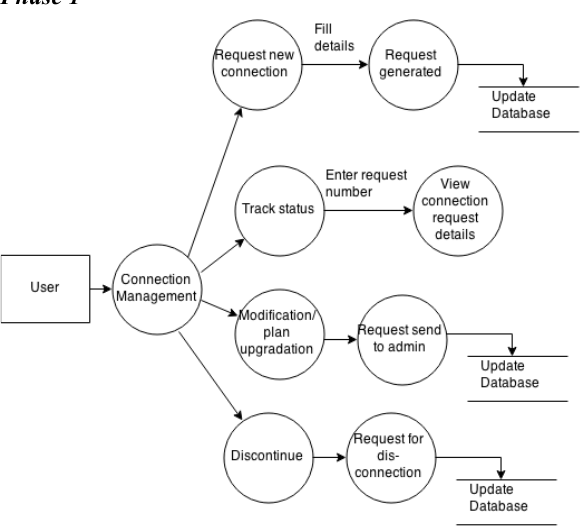
Figure 11. Connection Management System for the Integrated Application